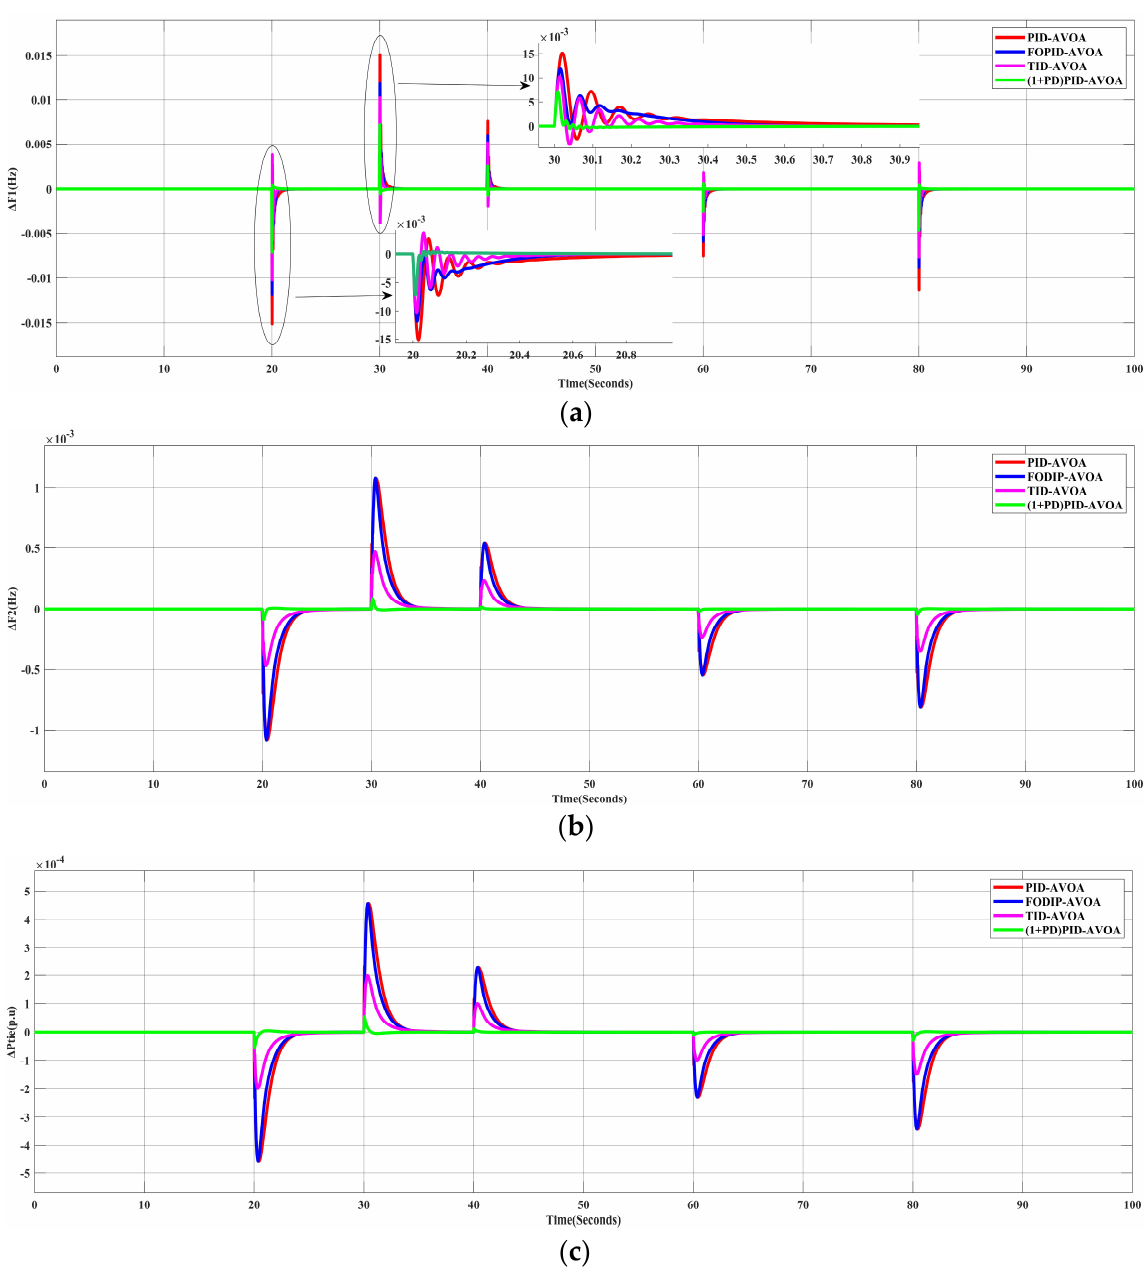
Figure 8. Random load profile.